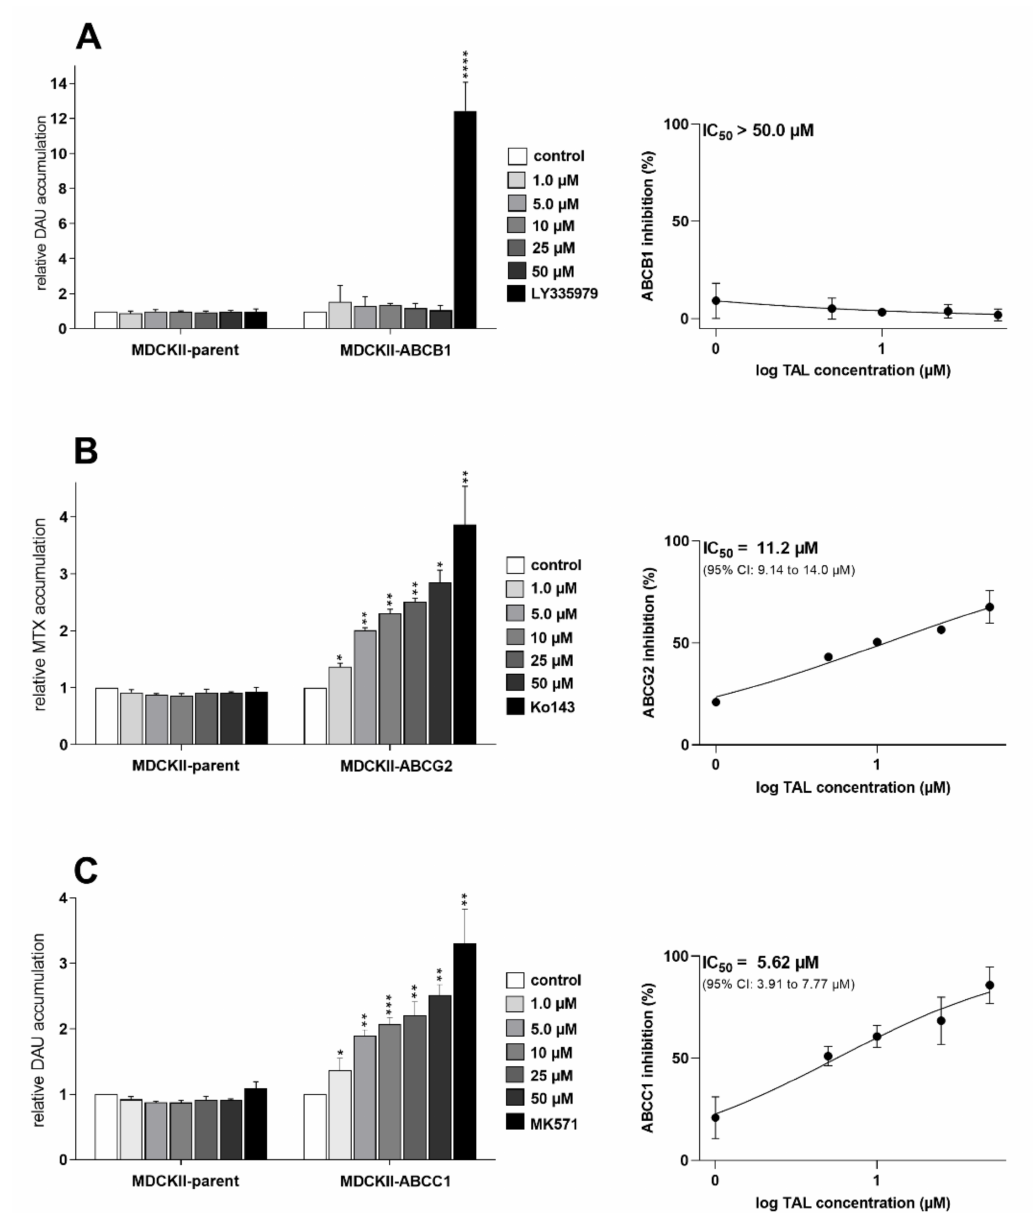
Figure 2. MDCKII cell accumulation studies showing effects of talazoparib on transport activities of ( A ) ABCB1, ( B ) ABCG2, and ( C ) ABCC1. The cells were pre-exposed to talazoparib or model inhibitors (LY335979, Ko143, and MK571, respectively) and then treated with fluorescent chemotherapeutics, daunorubicin, or mitoxantrone. After the substrate accumulation period, the cells were trypsinized, and flow cytometer was used to quantify the intracellular fluorescence. The plotted values of relative accumulation reflect a fold increase in the accumulation of the probe substrate caused by the tested compound; they are numerically expressed as ratios of relative fluorescence units (RFUs) from treated samples to RFUs of vehicle control. Model inhibitors and vehicle controls represented 100% inhibition and 0% inhibition, respectively; their values were applied during normalization of talazoparib data and calculation of its IC 50 values. Statistical analysis was accomplished using one- way ANOVA followed by Dunnett’s post hoc test (* p < 0.05; ** p < 0.01; *** p < 0.001; **** p < 0.0001 relative to control), while the presented data are means ± SD from three independent assays. DAU, daunorubicin; MTX, mitoxantrone; TAL,